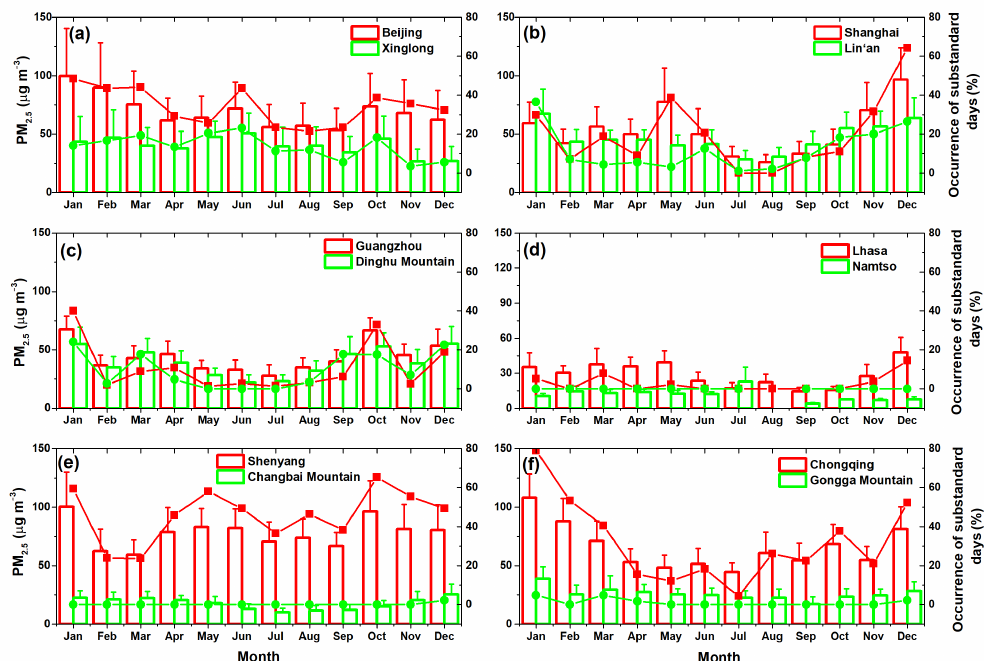
Figure 2. Monthly average PM 2 . 5 concentration (histogram, left coordinate) and the occurrence of substandard days in each month (dotted line, right coordinate) at urban and background sites in the (a) North China plain, (b) Yangtze River delta, (c) Pearl River delta, (d) Tibetan Autonomous Region, (e) North-east China region and (f) South-west China region. The error bar stands for the standard